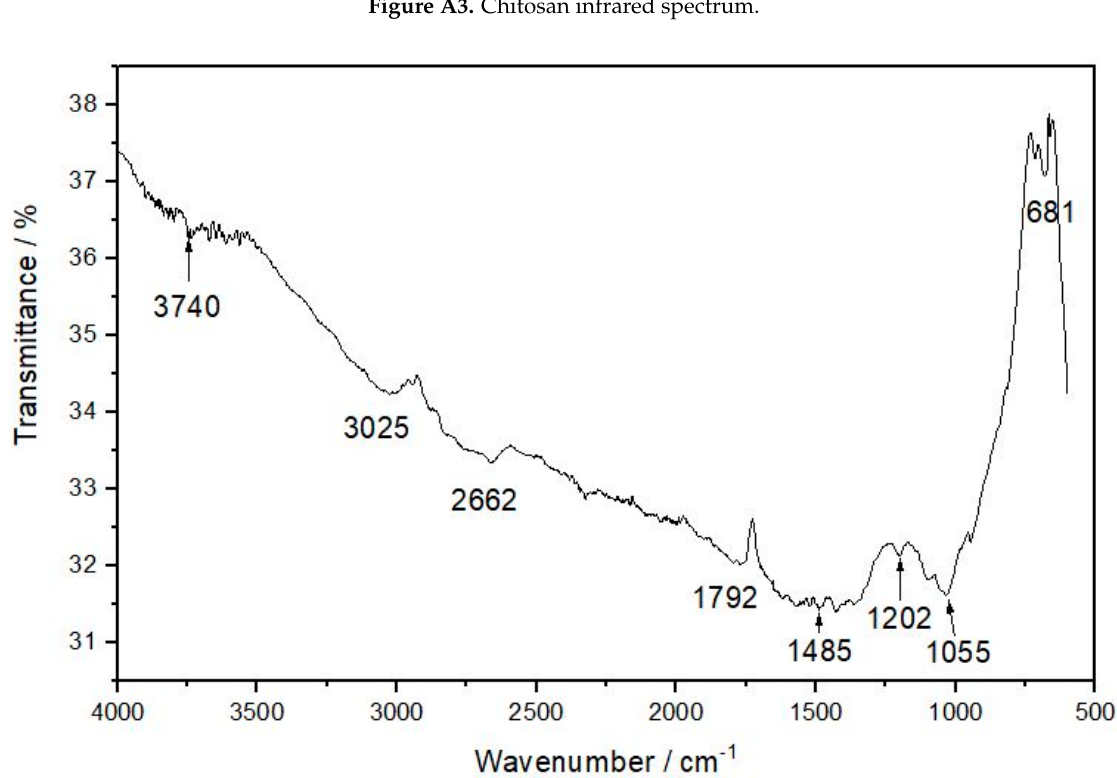
Figure A4. Magnetite infrared spectrum.